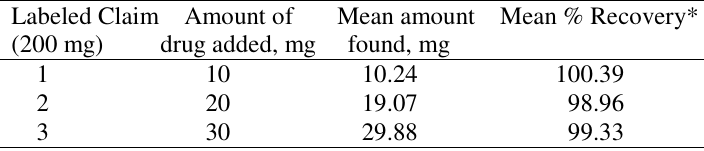
Table 5. The recovery studies for nevirapine by proposed method Labeled Claim Amount of Mean